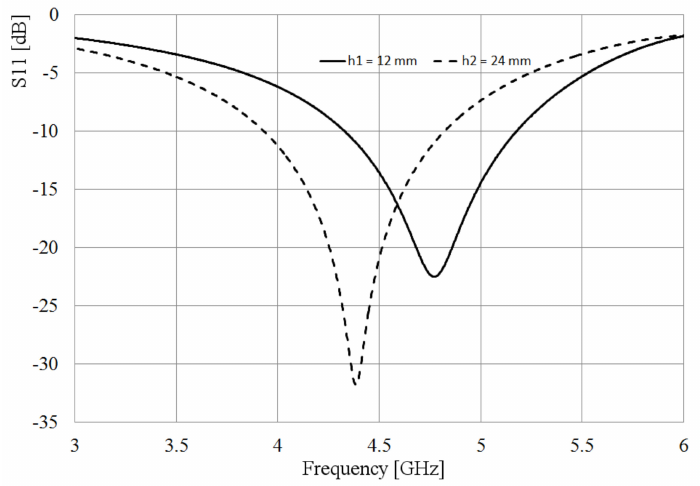
Figure 6. S11-parameter of the antenna for different box